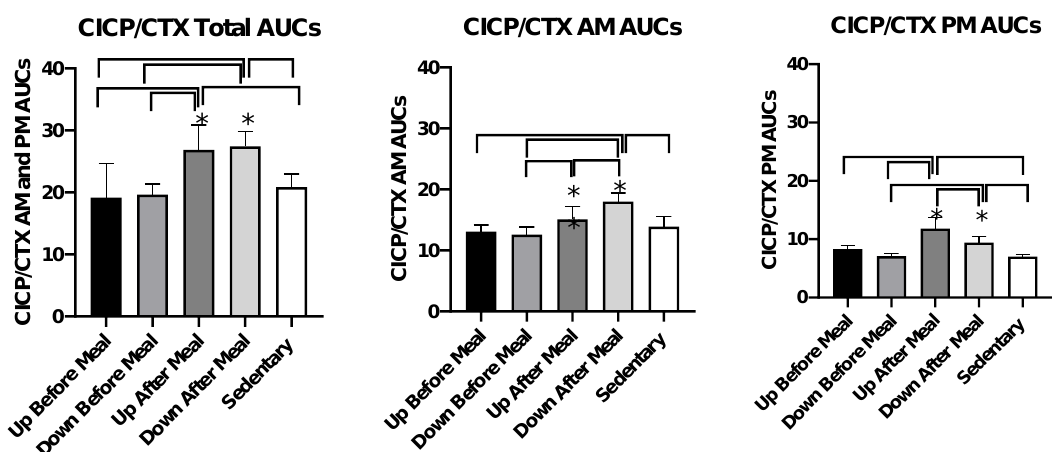
Figure 6. Postprandial CICP/CTX AUCs after the morning and afternoon meals combined (left) and after the morning (center) and afternoon (right) meals individually. Greatest increases in CICP/CTX AUCs were seen for the two exercise-after-meals trials (UAM and DAM) relative to sedentary trials both in the combined AUCs (left) and afternoon AUCs (right). The morning CICP/CTX AUCs remained higher only in the DAM relative to SED trial and two exercise-before-meals trials. Afternoon AUCs in UBM trial were also higher than in the DBM trial. * indicates significant difference relative to groups marked by the overhead bracket